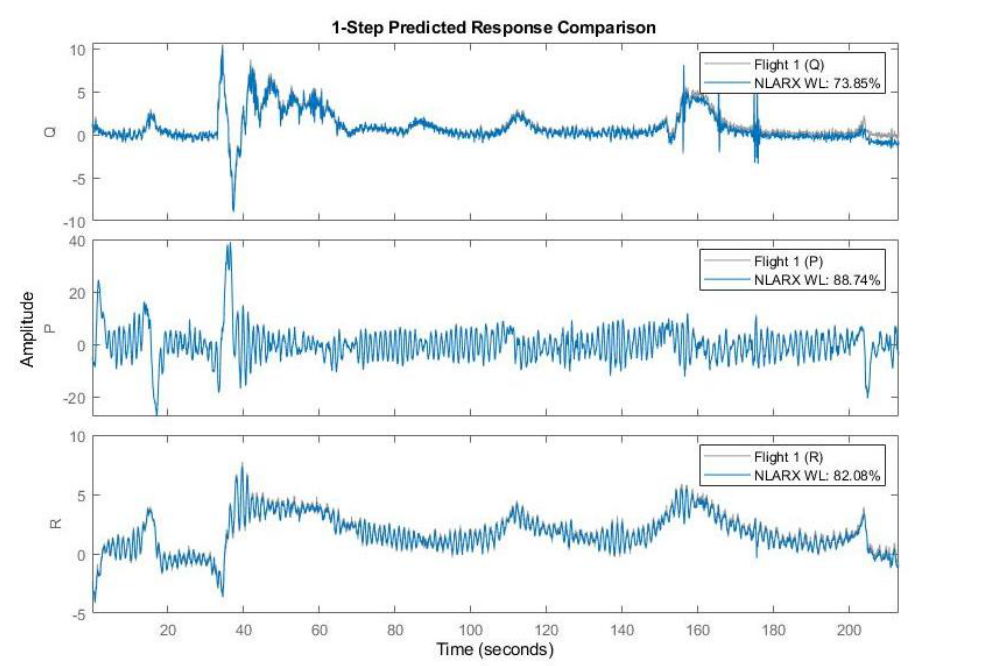
Figure 22. NLARX Wavelet Network Model